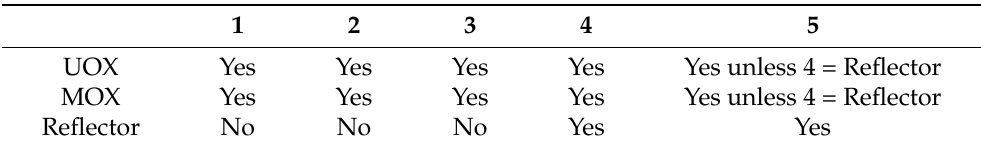
Table 1. Table showing possible domains within a system. The rows represent the material type of domain, and the columns represent the location within the system. UOX, Uranium Oxide; MOX, Mixed